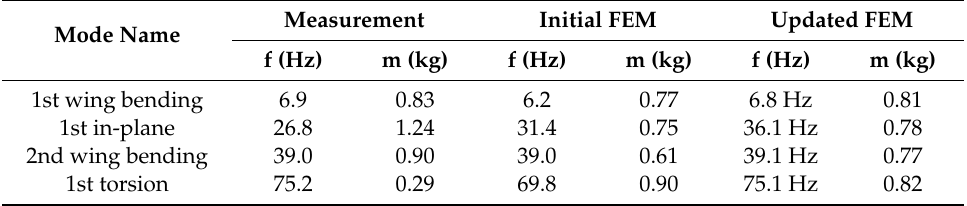
Table 4. Comparison of eigenfrequency (f) and generalized mass (m) of selected structural